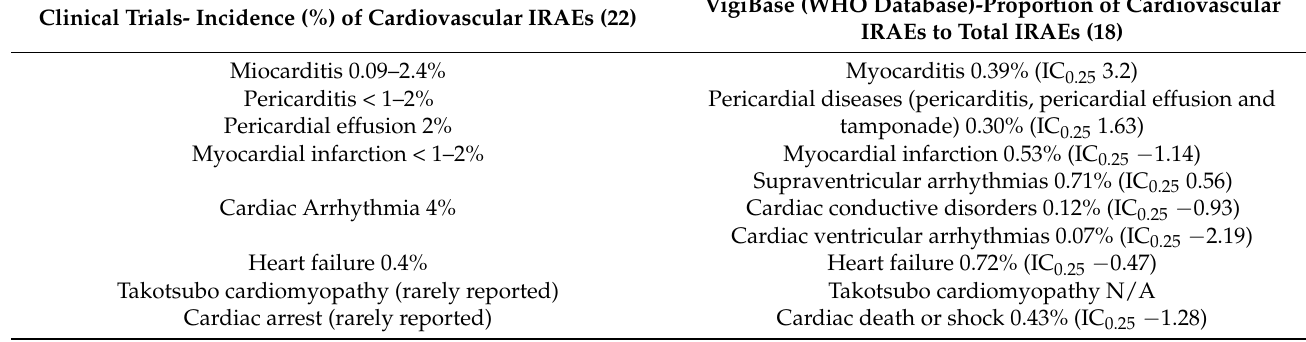
Table 1. Incidence of cardiotoxicity ICI-associated [13] and proportion of suspected drug-induced cardiovascular events reported with ICIs to the total spectrum of toxicity reactions (IRAEs) [14,15]. VigiBase collects reports of cardiovascular events associated with ICI versus those associated with other drugs. Compared with the full database, ICI treatment was associated with higher reporting of myocarditis (IC 0.25 3.20) and pericardial diseases (IC 0.25 1.63). [A positive IC 0.25 value (>0) is the traditional threshold used for statistical significance].